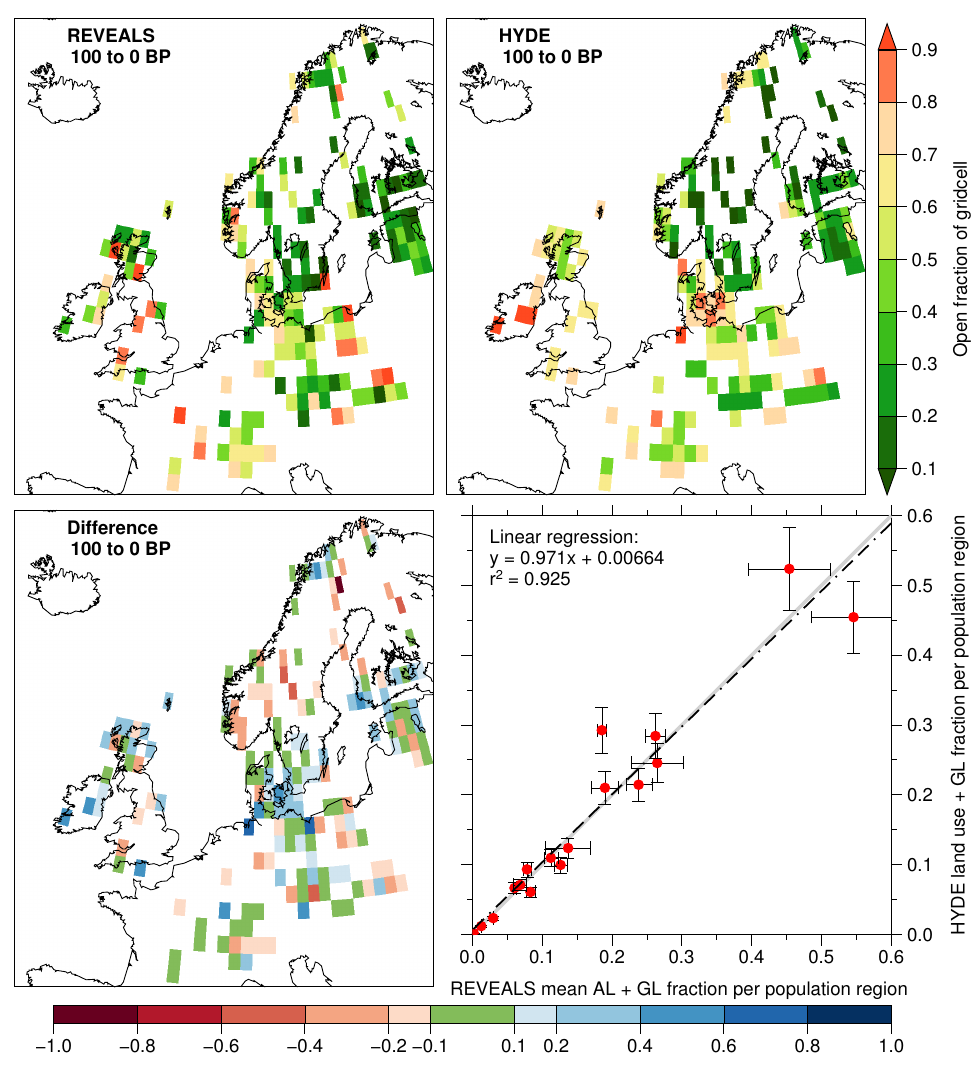
Figure 2. Comparison of the pollen-based REVEALS reconstruction with the HYDE land use scenario for the period 100–0 BP (AD 1850–1950). The top panels show the REVEALS open-land (AL + GL) fractions and the HYDE crop and pasture + natural treeless areas. The lower left panel displays the differences between the two datasets. In the lower right panel, a linear regression between REVEALS and HYDE openness fractions is shown, each dot representing a population